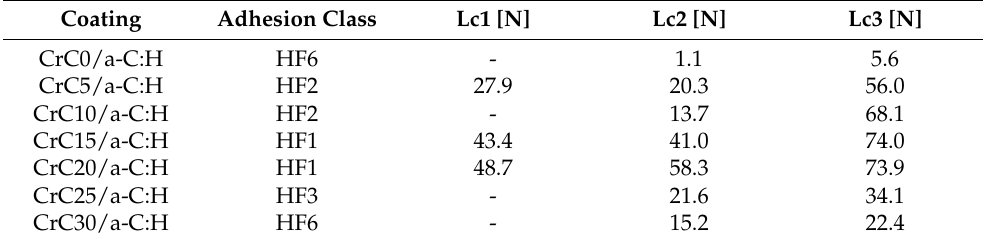
Table 2. Adhesion classes and critical loads of the CrC and CrC/a-C